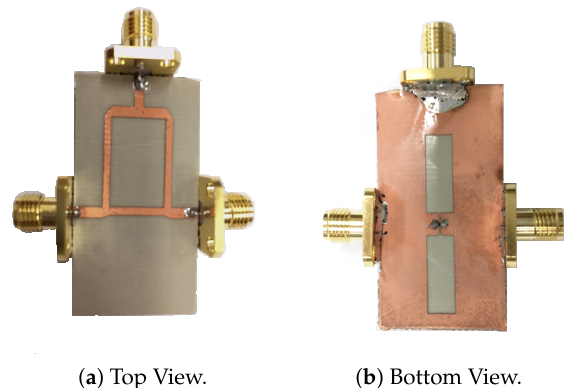
Figure 12. Photographs of the fabricated WPD circuit designed at 3